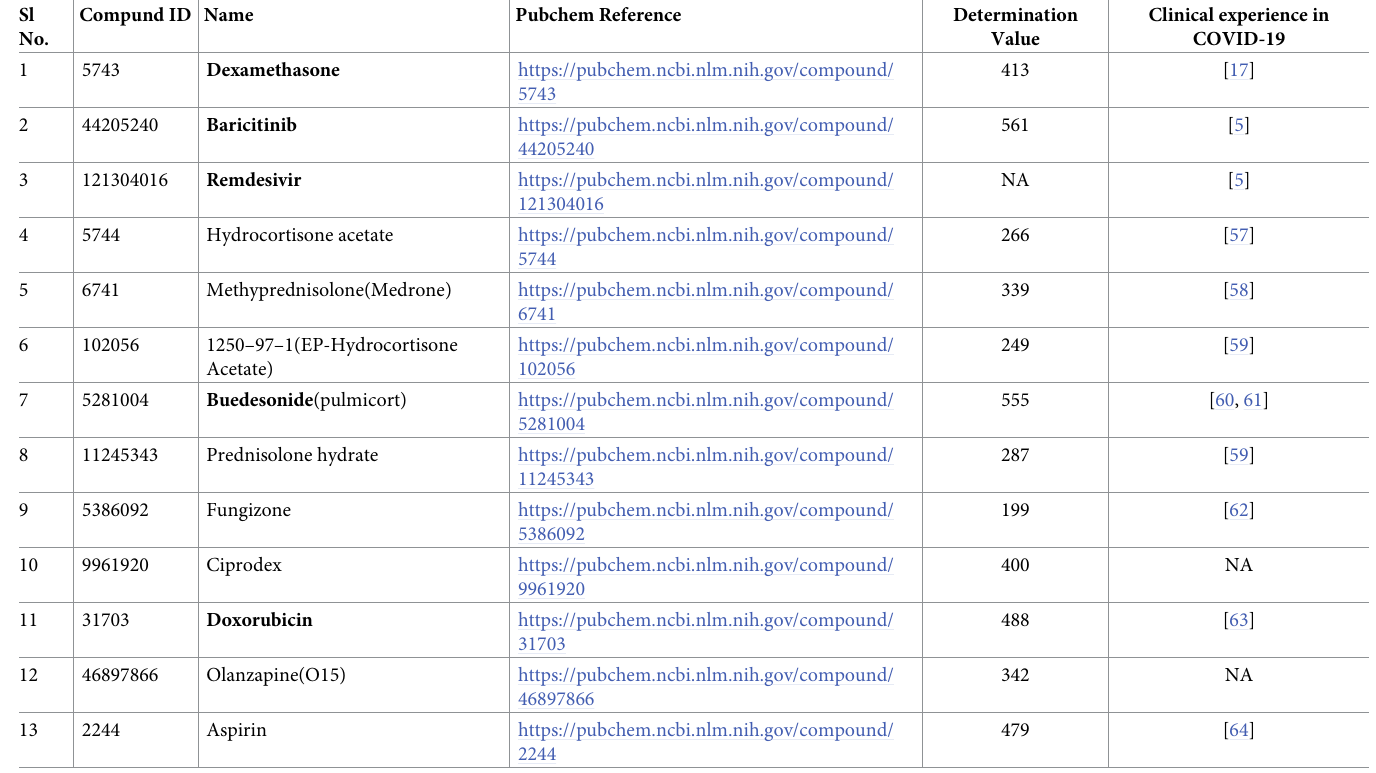
Reference drugs and the names of three drugs having the highest determination value are highlighted in bold letters. The bold shows reference drugs and the top two drugs selected based on the determination